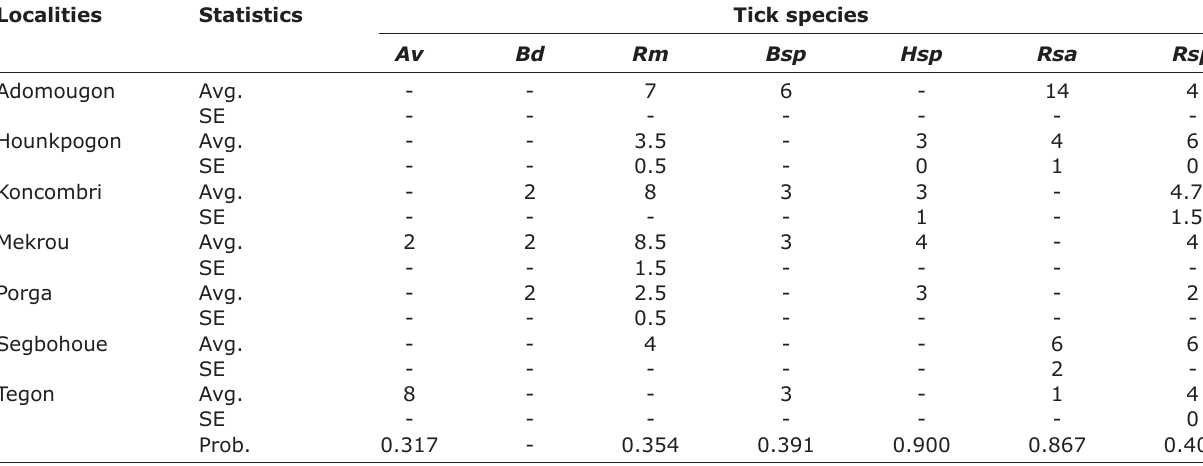
Table-3: Average number of ticks and standard error by location and tick species. Localities Statistics